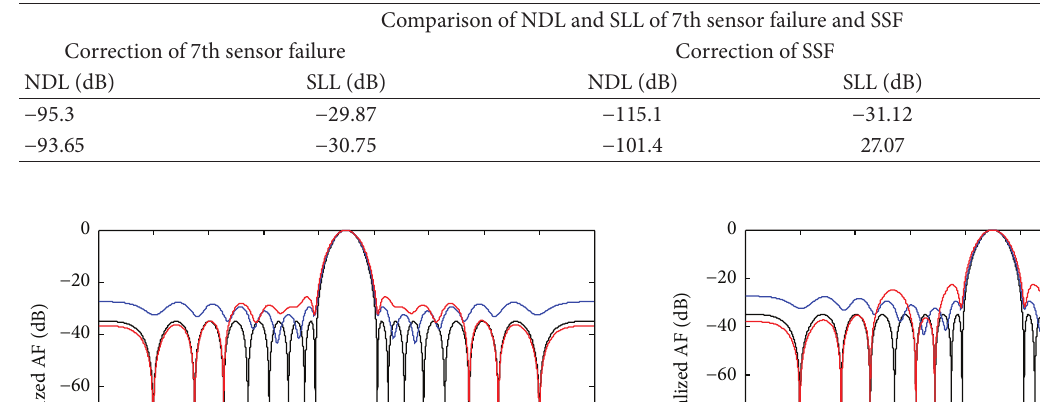
Table 4: Recovery of two nulls.